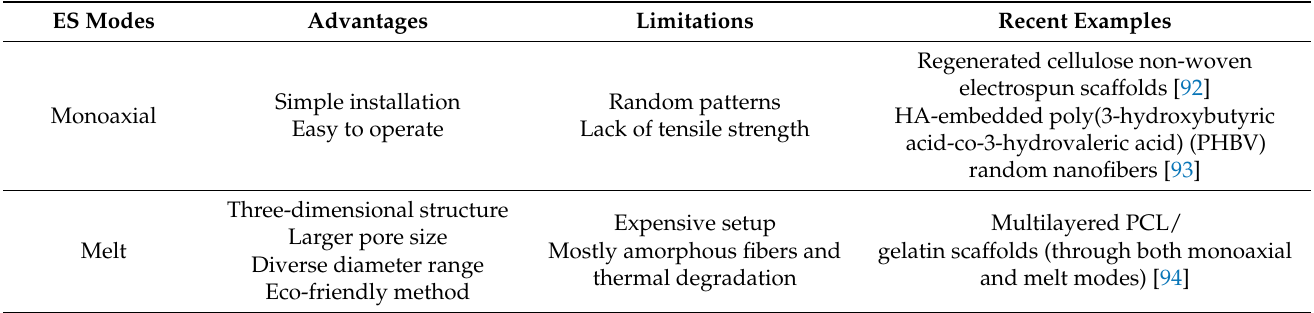
Table 2. A comparison of different modes of electrospinning (ES) for bone regeneration 1